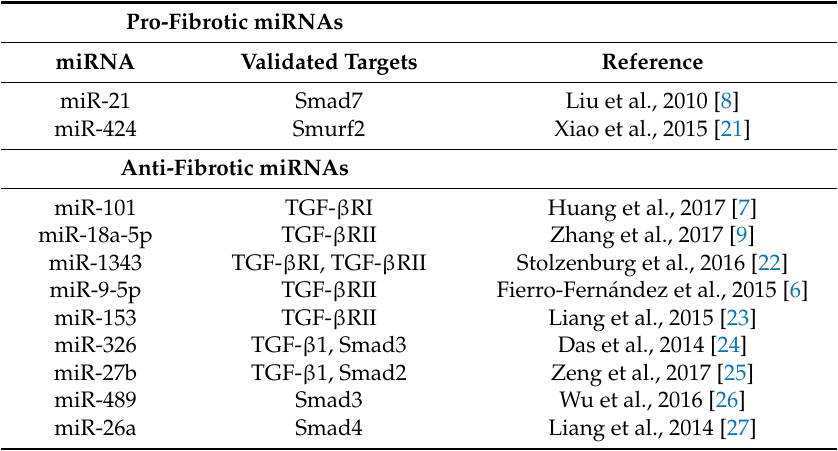
Table 1. miRNAs regulating the TGF- β signaling